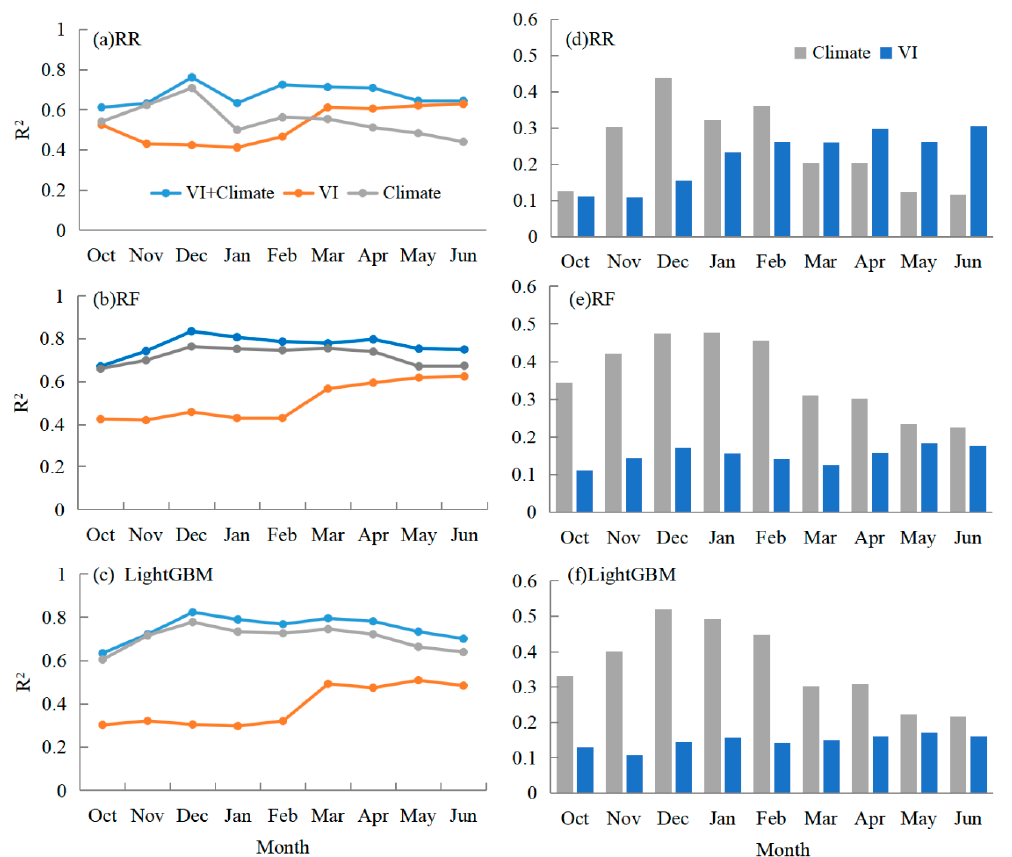
Figure 6. The temporal progression of the model performance based on the three methods (RR, RF, and LightGBM). The left panel shows the temporal progress of model performance according to each month (i.e., the prediction at any specific month contains input data covering the period from the beginning of the growing season to that specific month, thus the later period contains more inputs and usually has a higher performance). Blue refers to the model performance of using input sources including climate data and VIs; orange for VIs only inputted; and gray for climate data only. The right panel shows the di ff erences of model performance between combined input sources and VIs only (a blue column indicates the benefits from VIs, calculated by subtracting the orange line from the blue line in the corresponding left panel); and the di ff erences between VI + climate and climate only (a gray column indicates the benefits from VIs, calculated by subtracting the gray line from the blue line in the corresponding panel).